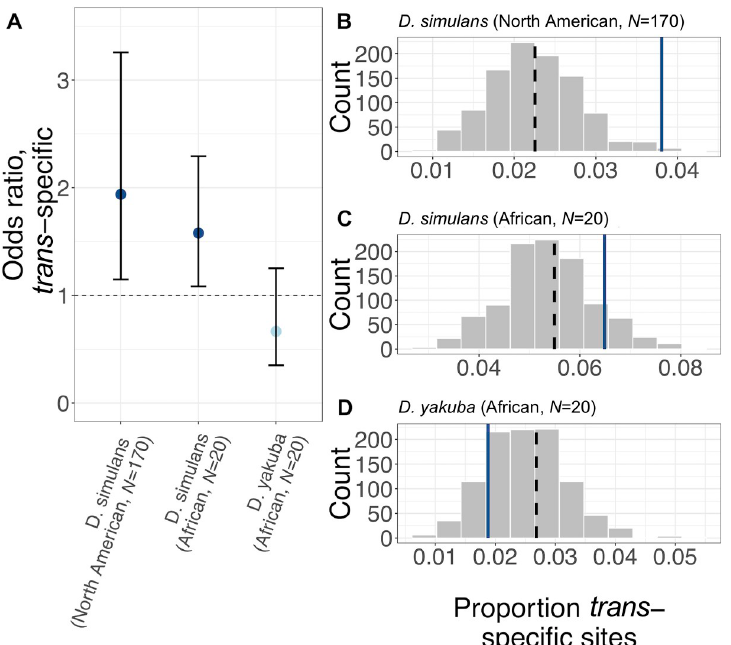
Fig 6. Signatures of balancing selection associated with antagonistic variants in two sister species, D . simulans and D . yakuba . (A) Odds ratio ( ± 95% CI) that a polymorphism’s trans -specific status varies with absolute GWAS effect size (regression coefficient), controlling for LH M MAF and genome-wide linked selection (see Materials and methods). An odds ratio > 1 indicates that sites with higher effect sizes are more likely to be trans -specific. The relationship between trans -specific status and effect size is presented for three datasets: a panel of 170 North American D . simulans genomes (left), 20 African D . simulans genomes (middle), and 20 African D . yakuba genomes (right). Colours indicate significant under- or overrepresentation (dark blue: P < 0.05; light blue: P > 0.05). Of the LD-independent sites considered in each sample, the number and percentage of trans -specific sites were N = 3,608 (2.2%), N = 7,466 (5.5%) in the 170- and 20-genome D . simulans datasets, respectively, and N = 2,760 (2.7%) in the D . yakuba dataset. (B) Histogram of the proportion of trans -specific polymorphisms for 1,000 sets of LD-pruned nonantagonistic SNPs that have been frequency and linked-selection matched to antagonistic SNPs. Blue line denotes mean proportion of trans - specific antagonistic SNPs; black dashed line denotes mean proportion of trans -specific nonantagonistic SNPs without any correction for LH M MAF or linked selection. Trans -specific status was determined by considering polymorphism data from a panel of 170 North American D . simulans genomes. (C) Same as B, with trans -specific status derived from polymorphism data from a panel of 20 African D . simulans genomes. (D) Same as B., with trans -specific status derived from polymorphism data from a panel of 20 African D . yakuba genomes. Data and code underlying this figure can be found at https://doi.org/10.5281/zenodo.2623225. GWAS, genome-wide association study; LD, linkage disequilibrium; MAF, minor allele frequency; SNP, single nucleotide